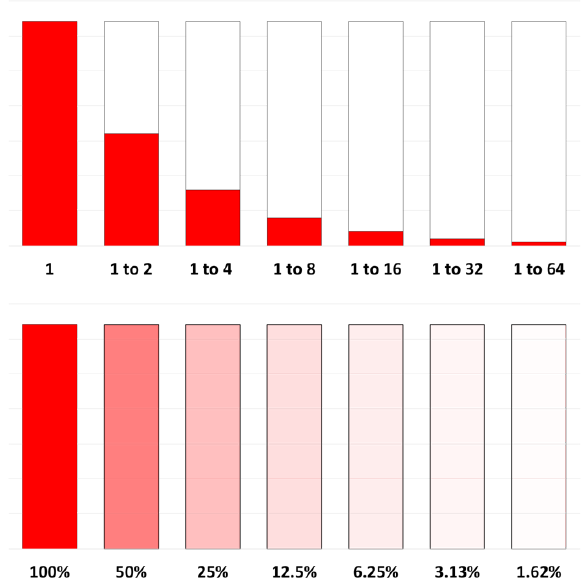
Figure 1. Scalar dilution of a concentrate (red) active substance in a solvent (white). Seven progressive dilutions are shown, starting from the mother liquor and ending with the sixth (1/64). The panel above shows the exponential decrease of the concentration form the arbitrary level of “one unit” to that corresponding to the sixth dilu- tion. The fading of color of a solution subject to the progressive 1:2 dilution is exemplified in the panel